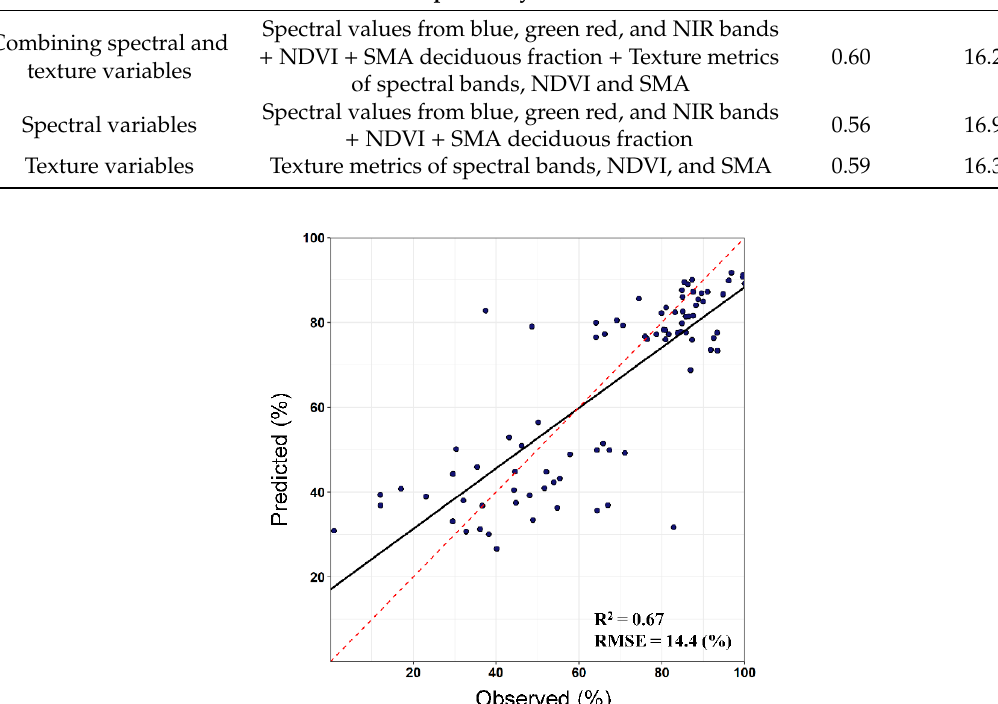
Table 3. Evaluation statistics for predicting tree species deciduousness from spectral data (bands, normalized difference vegetation index (NDVI), and spectral mixture analysis (SMA)) texture variables and both sets of data using random forest.